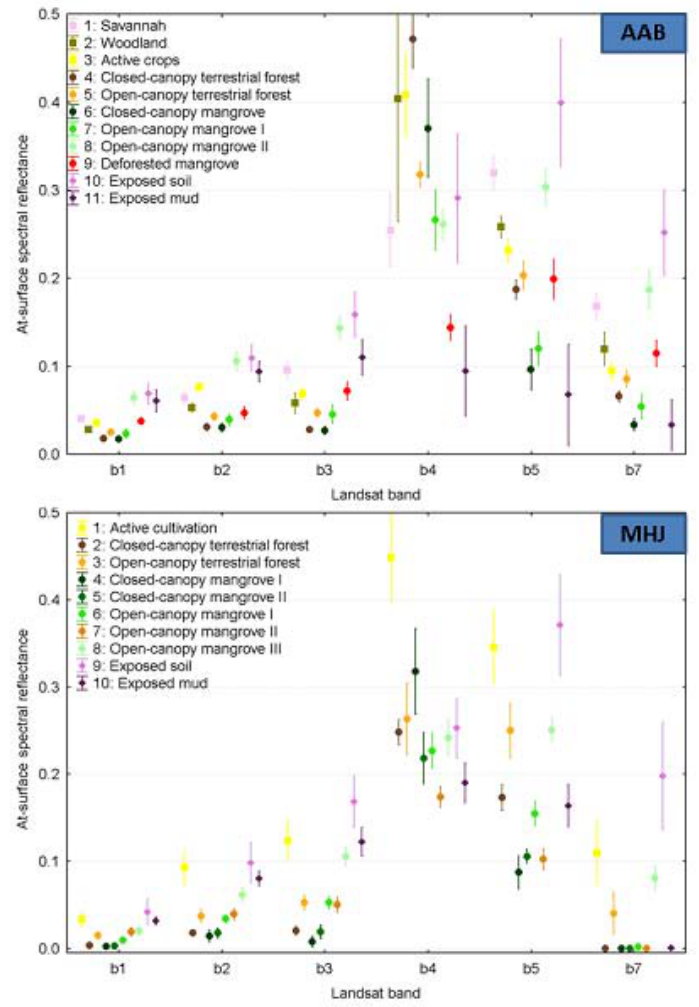
Figure 6. The mean spectral reflectance ( ˘ 1 standard deviation) of mapped classes for Ambaro-Ambanja Bays (AAB) and Mahajamba Bay (MHJ) (adapted from